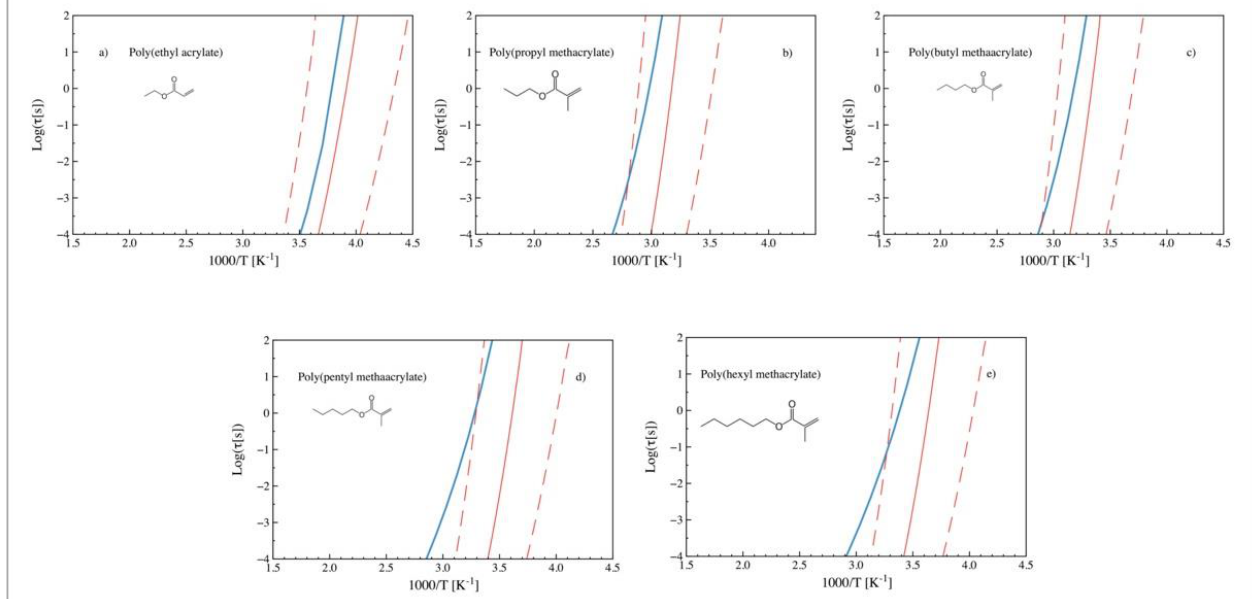
Figure 5. Experimental (blue) and predicted (red) relaxation times (obtained from ECNLE theory) vs. 1000/T (n-alkyl acrylates, with n ranging from 2 to 6). The corresponding monomeric chemical structures are also shown. ( a ) Poly (ethyl acrylate) [27], ( b ) poly (propyl methacrylate), ( c ) poly (butyl methacrylate), ( d ) poly (pentyl methacrylate) [27], and ( e ) poly (hexyl methacrylate) [27]. The plots correspond to predictions after introducing the scaling parameter ( a ) for linear tailed polymers.